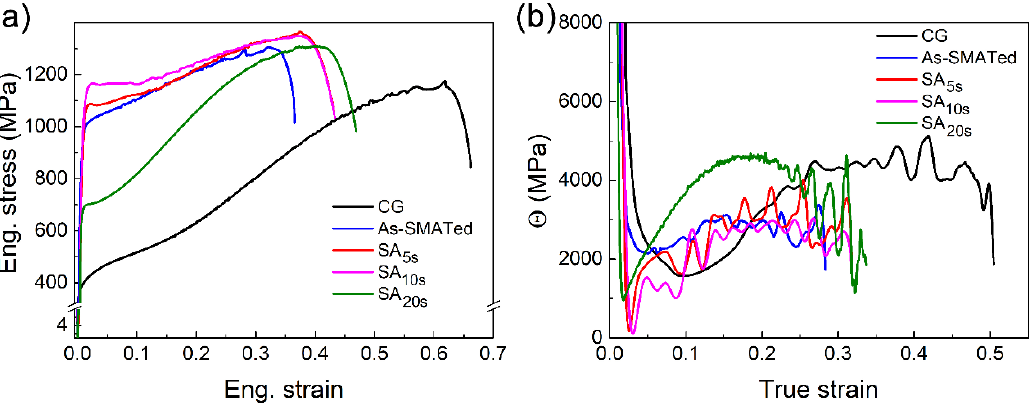
Figure 5. Comparison of the tensile responses of gradient samples: ( a ) engineering stress-strain curves and ( b ) strain hard- ening rate (Θ).